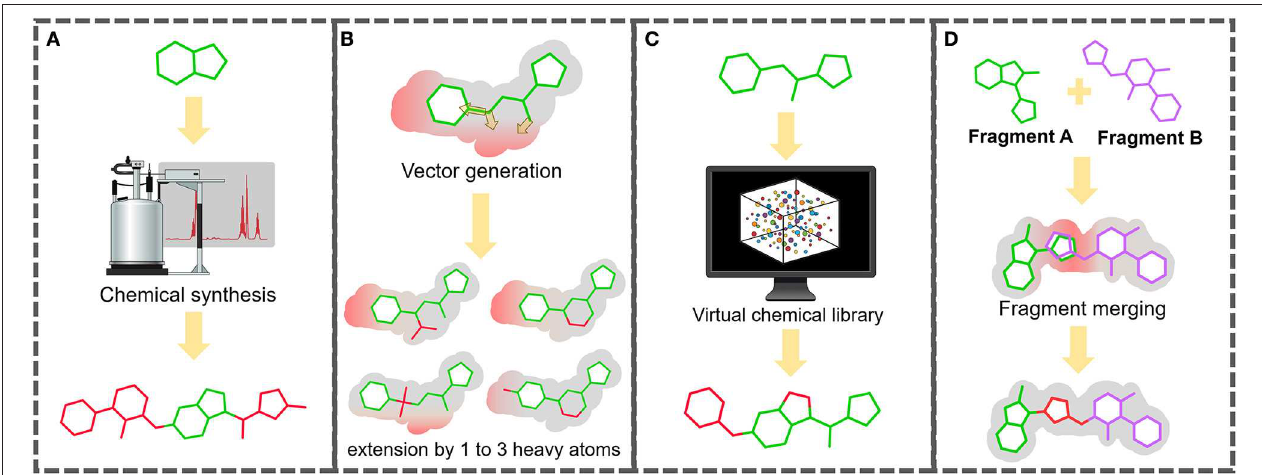
FIGURE 1 | Multiple routes to expanding fragment to more drug-like molecule with improved binding affinity. (A) Traditional medicinal chemistry route: knowledge-based design and synthesis. (B) “Small steps” route: successive cycles of extension of the fragment hit by 1–3 heavy atoms through vectors defined by high-resolution structural characterization methods, such as X-ray crystallography. (C) “Large leaps” or “SAR by catalog” route: from fragment to rule of 5 compliant molecules using virtual screening of commercial compound libraries. (D) Fragment merging route: bridging two overlapping fragments bound at neighbor sites. Regardless of the route, expanded fragments should be checked for biological activity using in vitro , ex vivo, or in vivo